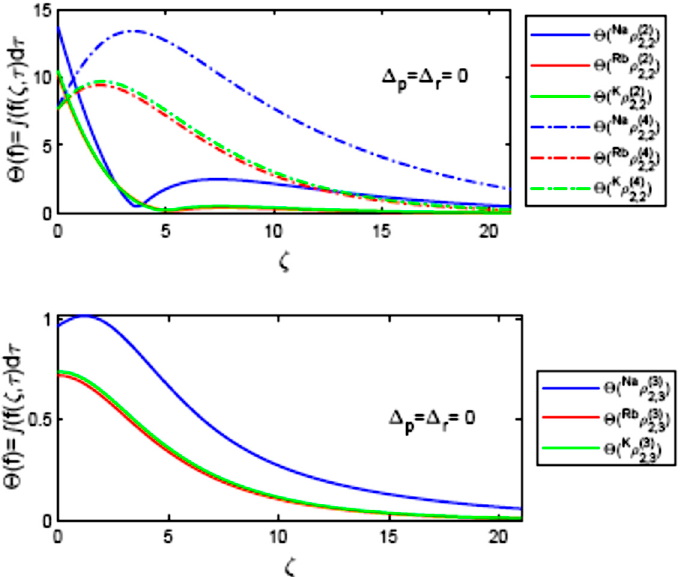
Figure 10. Space dependence of the time integral of quadrupole, octupole, and hexadecapole mo- ments of the DM for different vapours. The initial pulse profiles are depicted in Figure 2.